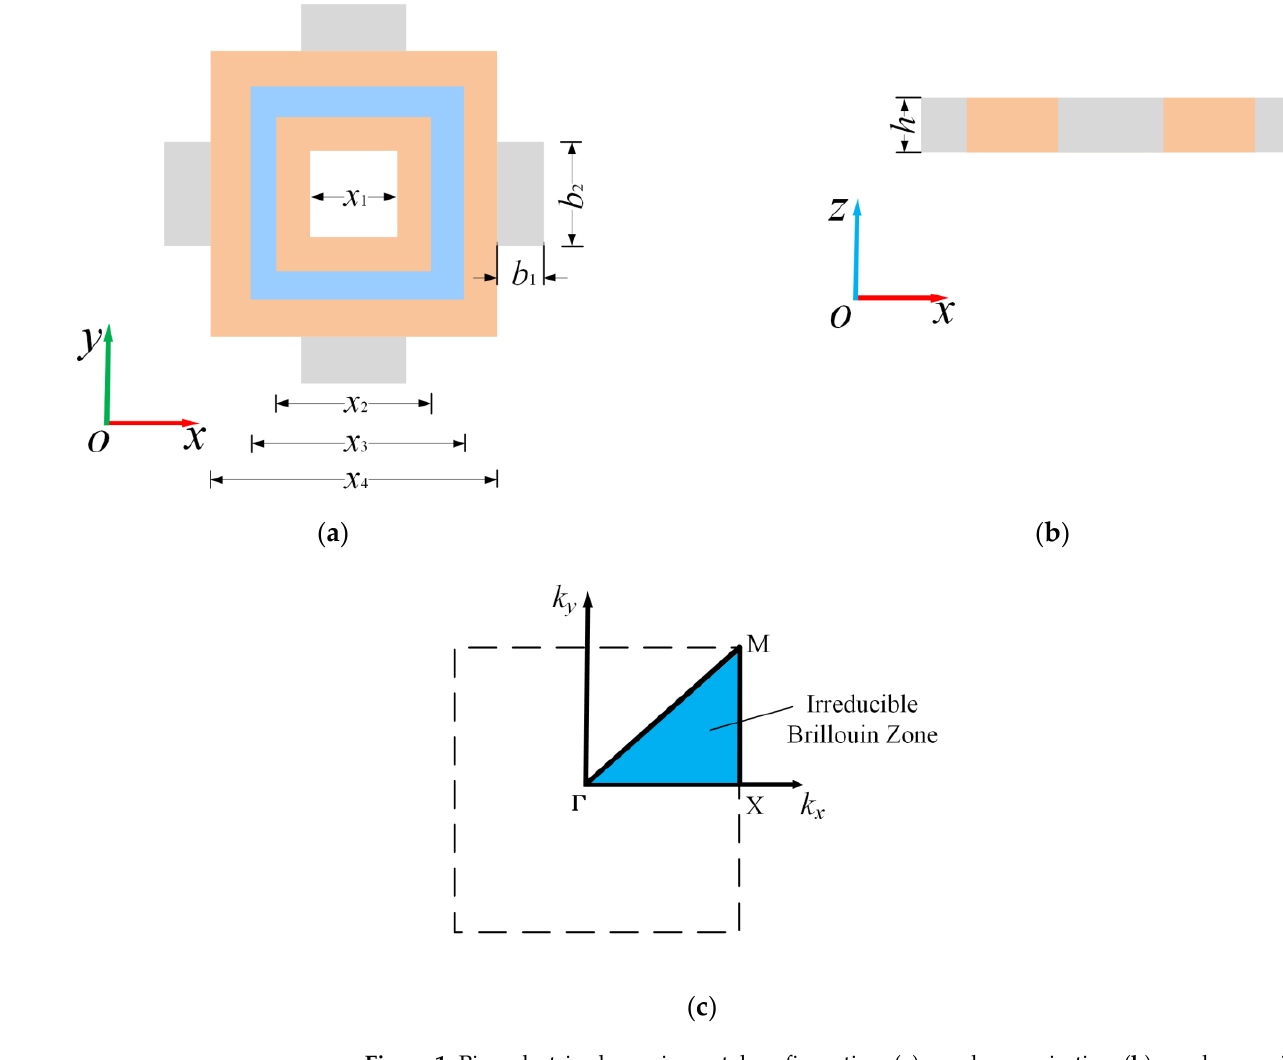
Figure 1. Piezoelectric phononic crystal configuration: ( a ) x - y plane projection; ( b ) x - z plane projection; ( c ) The first Brillouin Zone and the Irreducible Brillouin Zone.